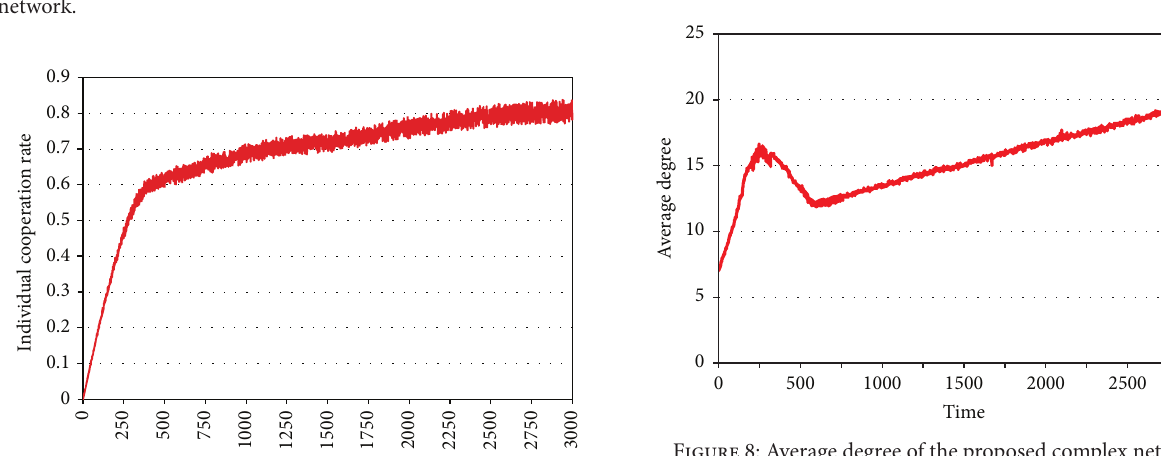
Figure 8: Average degree of the proposed complex